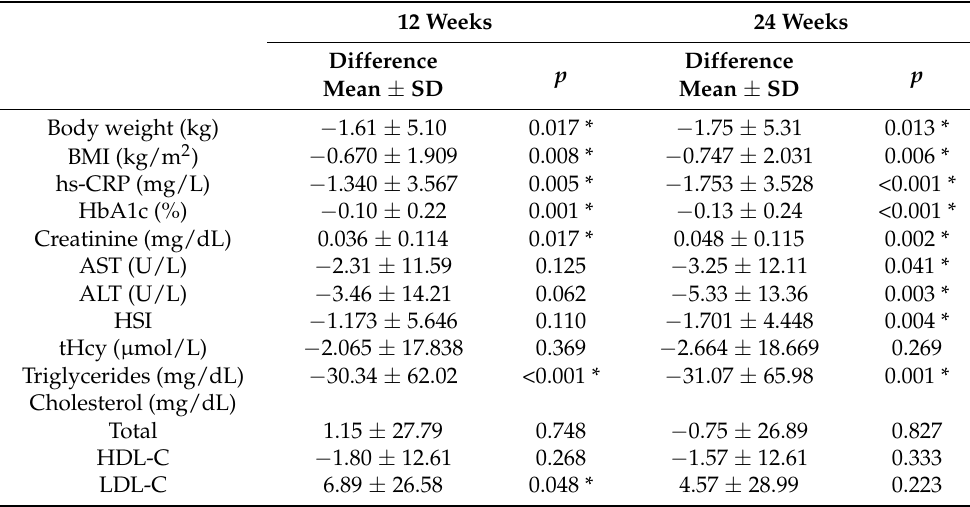
Table 2. Change in factors from baseline in zonisamide-treated